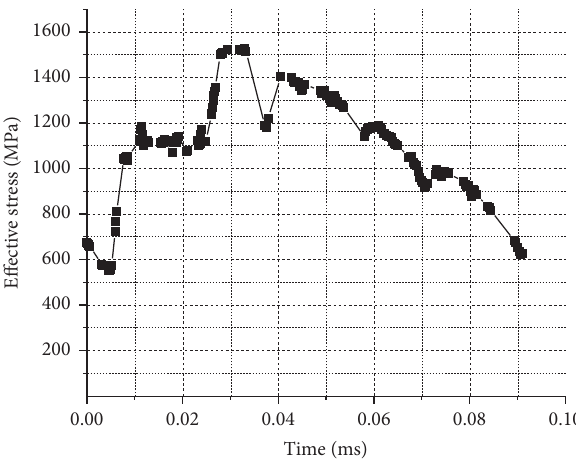
Figure 24: Effective stress-time history curve of point